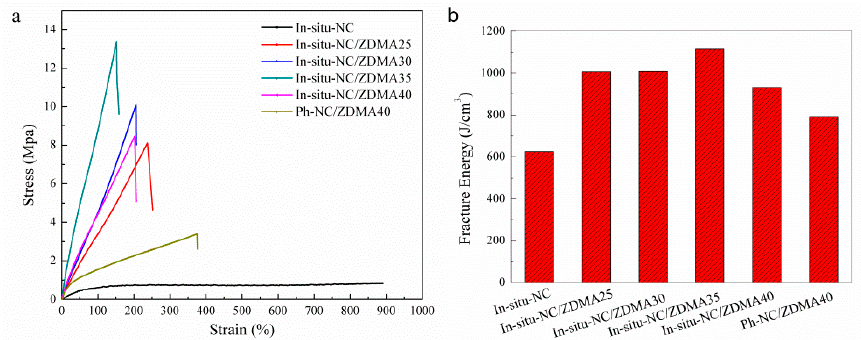
Figure 5. Crosslinking density of ( a ) in-situ-NC/ZDMA40 under different curing times, ( b ) Crosslinking density of in-situ-NC, in-situ-NC/ZDMAs, and ph-NC/ZDMA40.